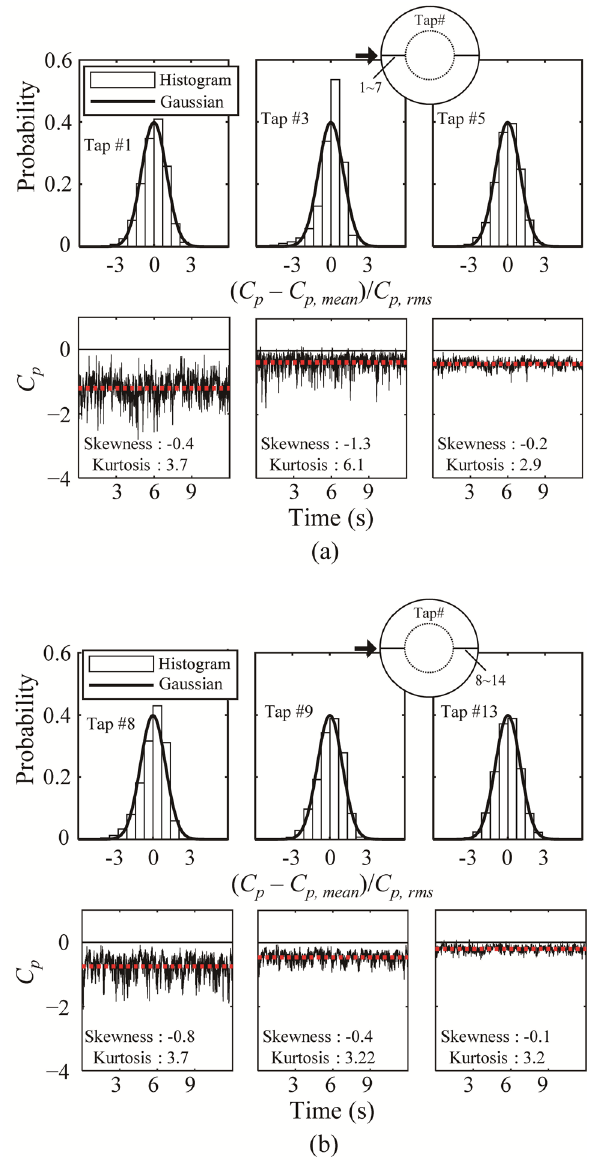
Figure 7. Histogram and time history of the pressure coefficient on external roof surface: ( a ) windward and ( b ) leeward regions.